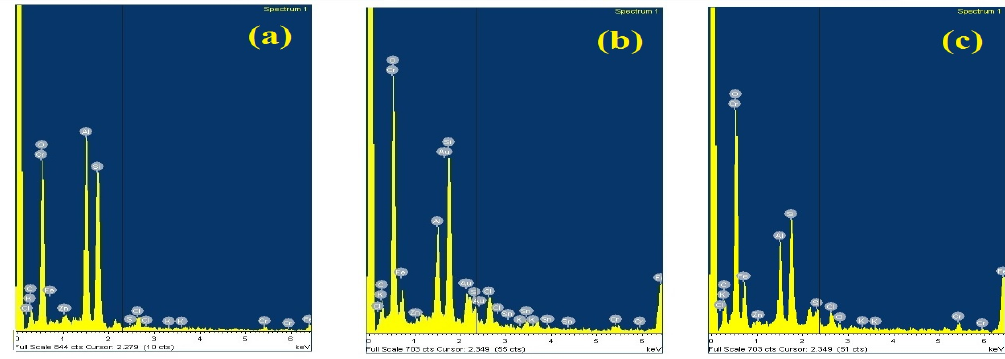
Figure 10. EDAX spectra of tracked samples: ( a ) Fresh, ( b ) thermal ‐ aged, ( c ) water ‐ aged. Table 3. Elemental composition analysis of the tracked samples-with EDAX. Elements Fresh Thermal-Aged